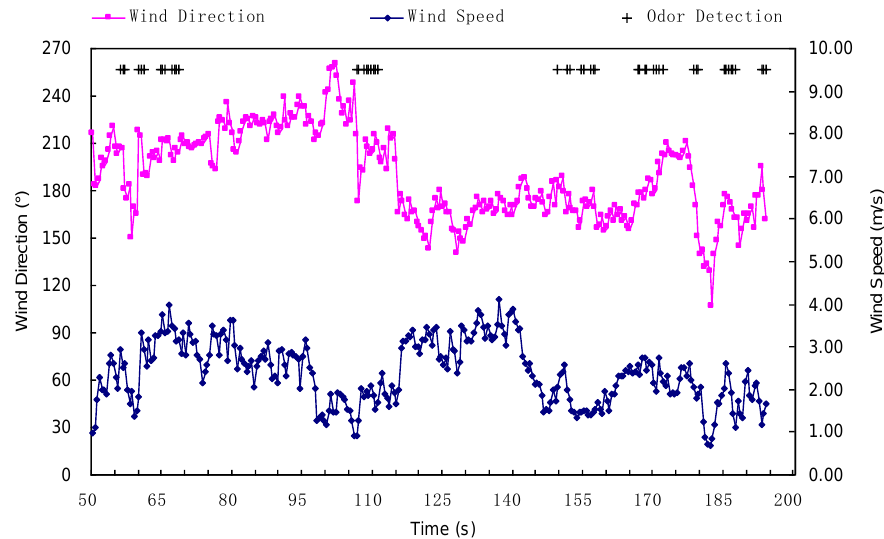
Figure 10. Instantaneous wind directions/speeds and chemical-detection events during the ERP phase shown in Figure 9.